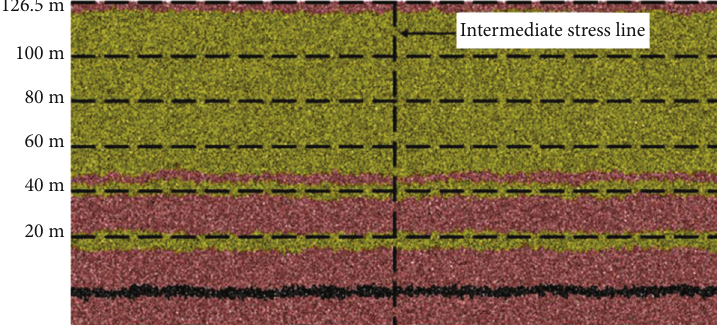
Figure 7: Layout of monitoring lines in numerical model.